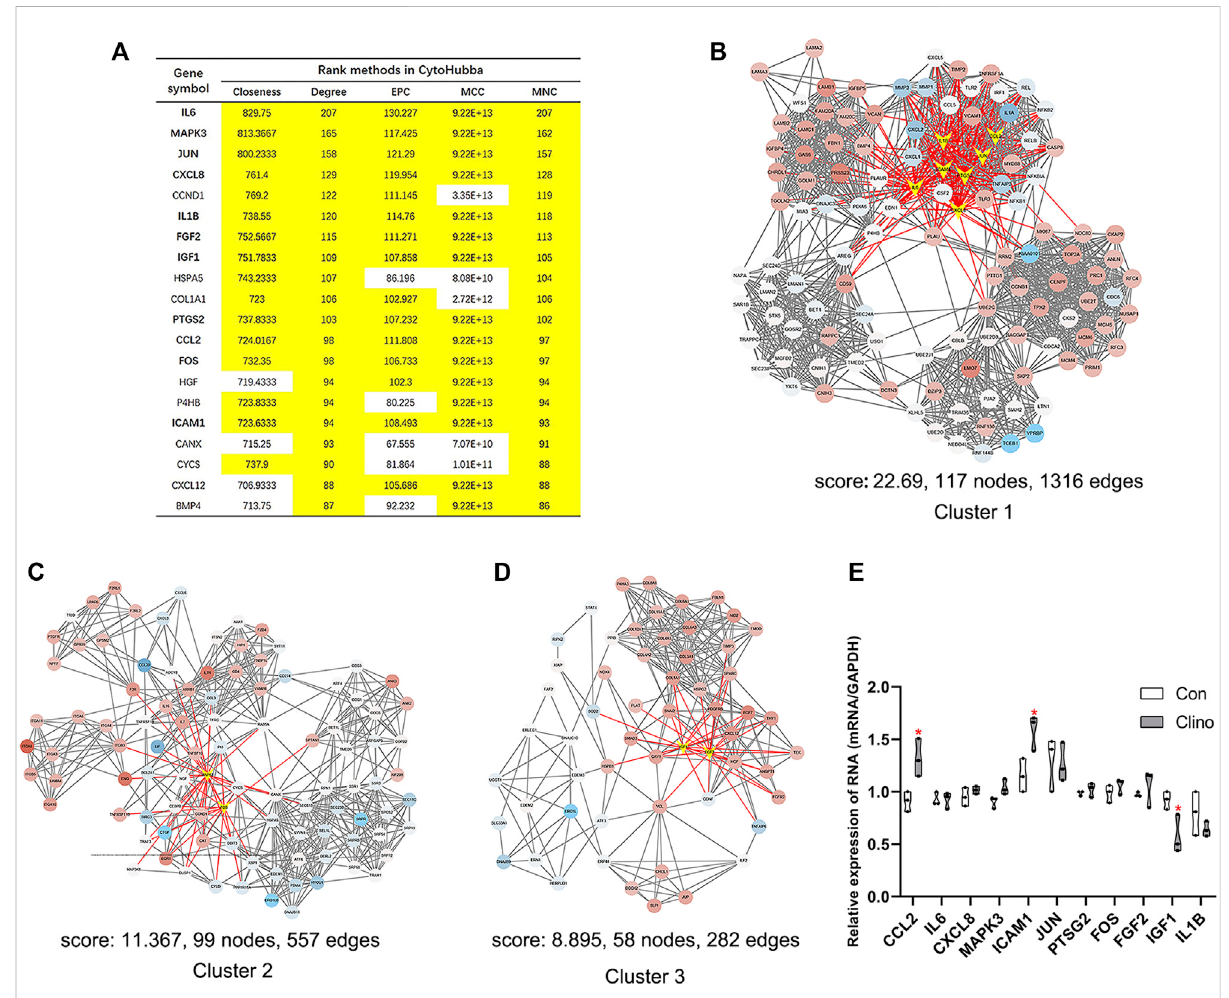
FIGURE 3 Identi fi cation of hub genes and essential gene cluster modules in the PPI network of DEGs in the GSE100900 dataset (A) The hub genes identi fi edby fi vealgorithms,includingdegree,MCC,MNC,EPC,andcloseness.Thosemarkedinyellowindicatethattheirratingsrankinthetop20of their respective algorithms (B – D) The top three modules identi fi ed by MCODE. The V-shape in yellow indicates hub genes (E) qRT-PCR for the expression of 11 hub genes in hMSCs under clinorotation-microgravity condition for 72 h. Data are the mean ± SD. * p < 0.05, ** p <